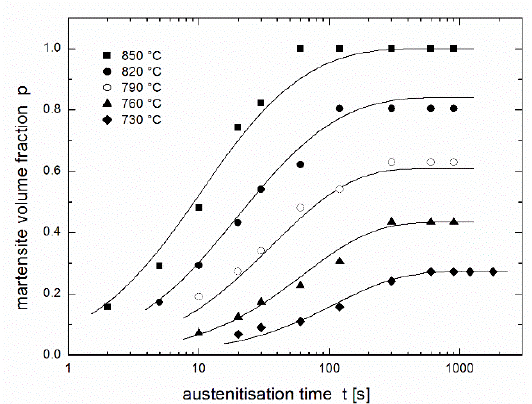
Figure 5. Martensite volume fraction in dual phase steel after austenitisation at various temperatures during various dwells [17] fitted using the equation of autoinhibition (3) and the modified Arrhenius equation (Equation (11)) (all temperatures were fitted together).